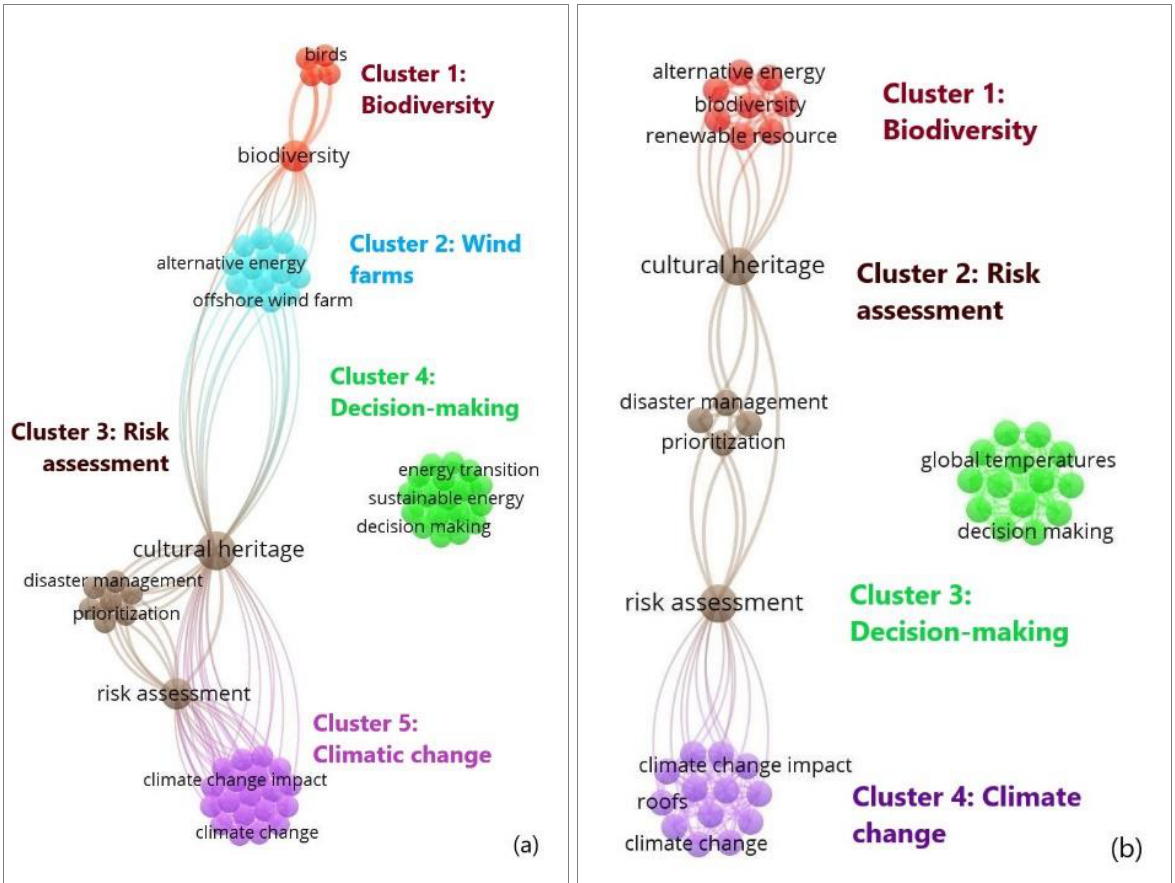
Figure 13. Scientific landscape of of wind energy and architectural heritage keywords: ( a ) 71 key- words; ( b ) 57 indexed keywords (source: Author ’ s elaboration using VOSviewer, based on Scopus data).